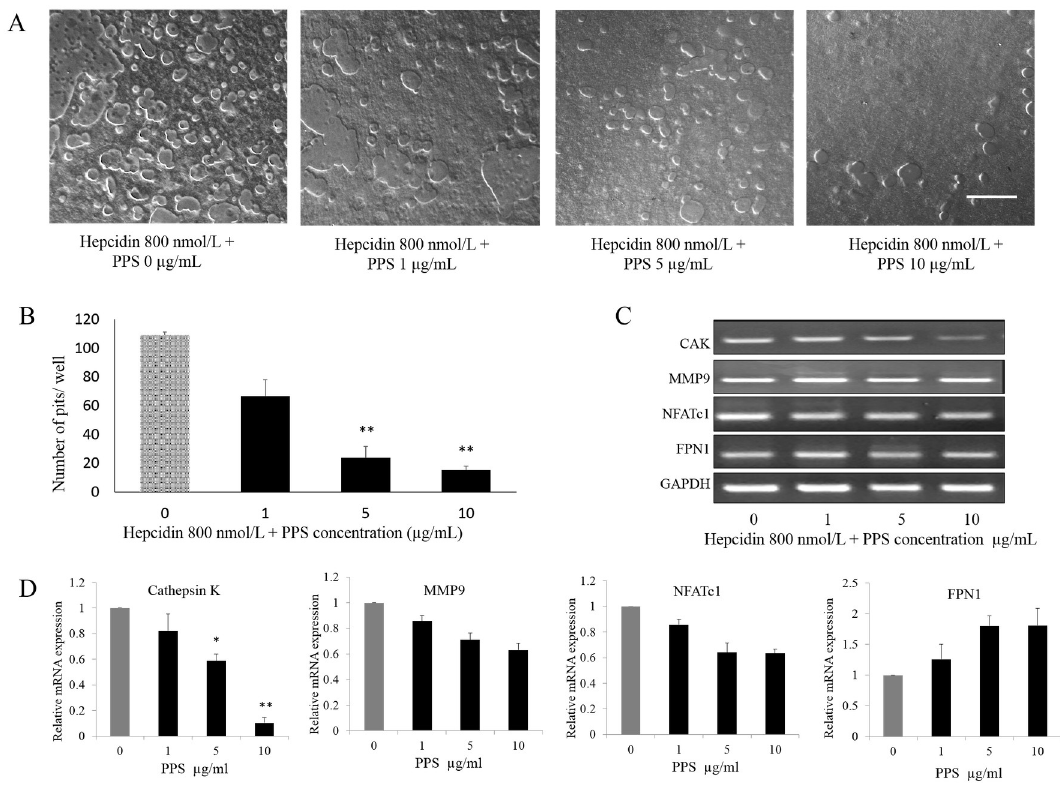
Fig 4. PPS inhibits bone resorption and OC specific genes. Canine BMMs, cultured with M-CSF (20 ng/mL), RANKL (50 ng/mL) and 800 nmol/L hepcidin 1 for 7 days with or without indicated doses of PPS. (A) The cells were washed and the resorption pits were counted. (B) The numbers of pits were analyzed with Image-J software. Scale bar- 200 μ m. Column indicates means ± SE of three experiments performed in triplicate. (C) and (D) Gene expression of CTK, MMP9, NFATc1 and FPN1 was investigated. Quantitative qPCR showed that PPS downregulates the gene expression of MMP9, NFATc1 and CTK (CTK at 5 and 10 μ g/mL of PPS; p < 0.05) while upregulating FPN1 expression in concentration manner. Data expressed as mean ± SE for each PPS concentration after normalizing for the expression of the GAPDH. Means with � are significantly different from 0 μ g/mL of NaPPS ( � p < 0.05, �� p < 0.01).